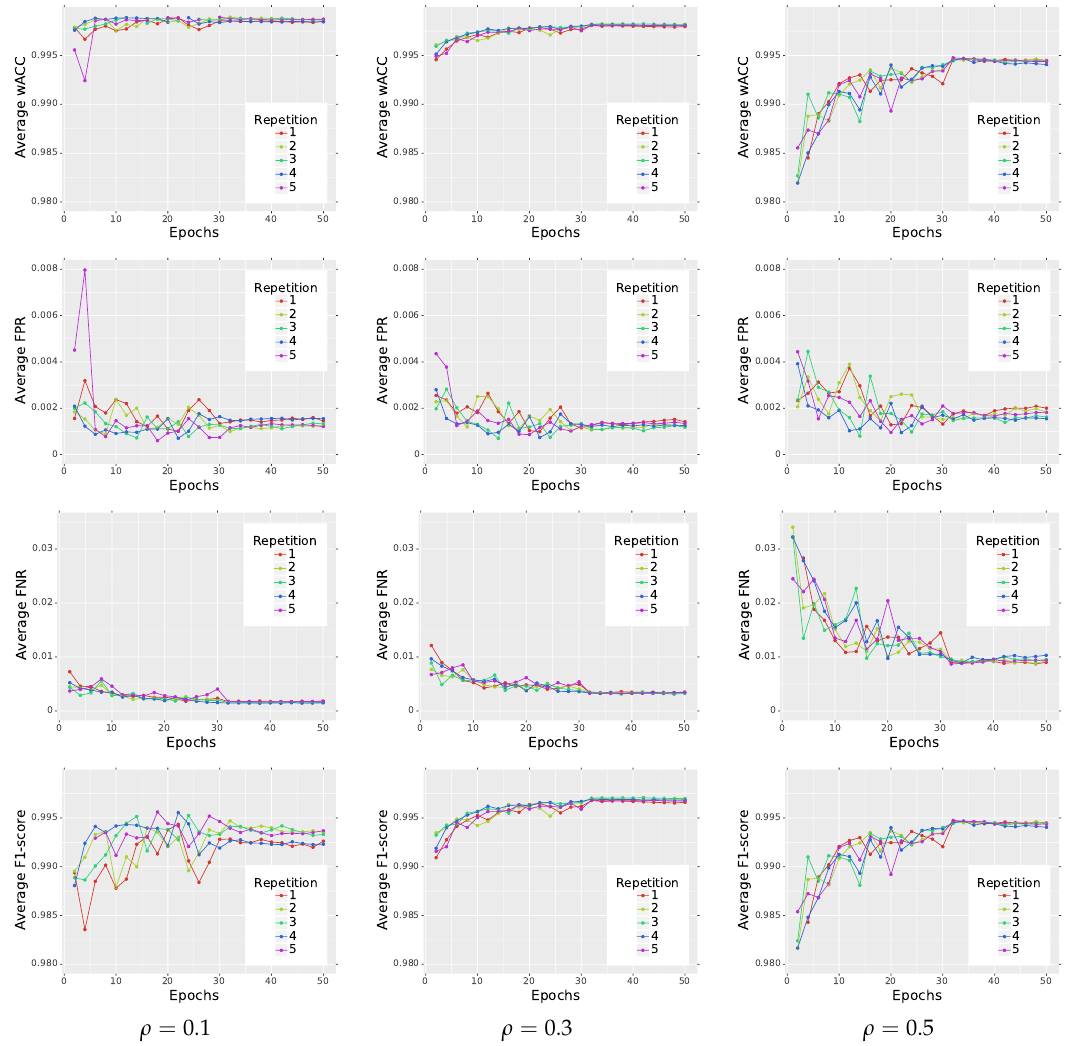
Figure 6. Repeatability of the training procedure on BSD500